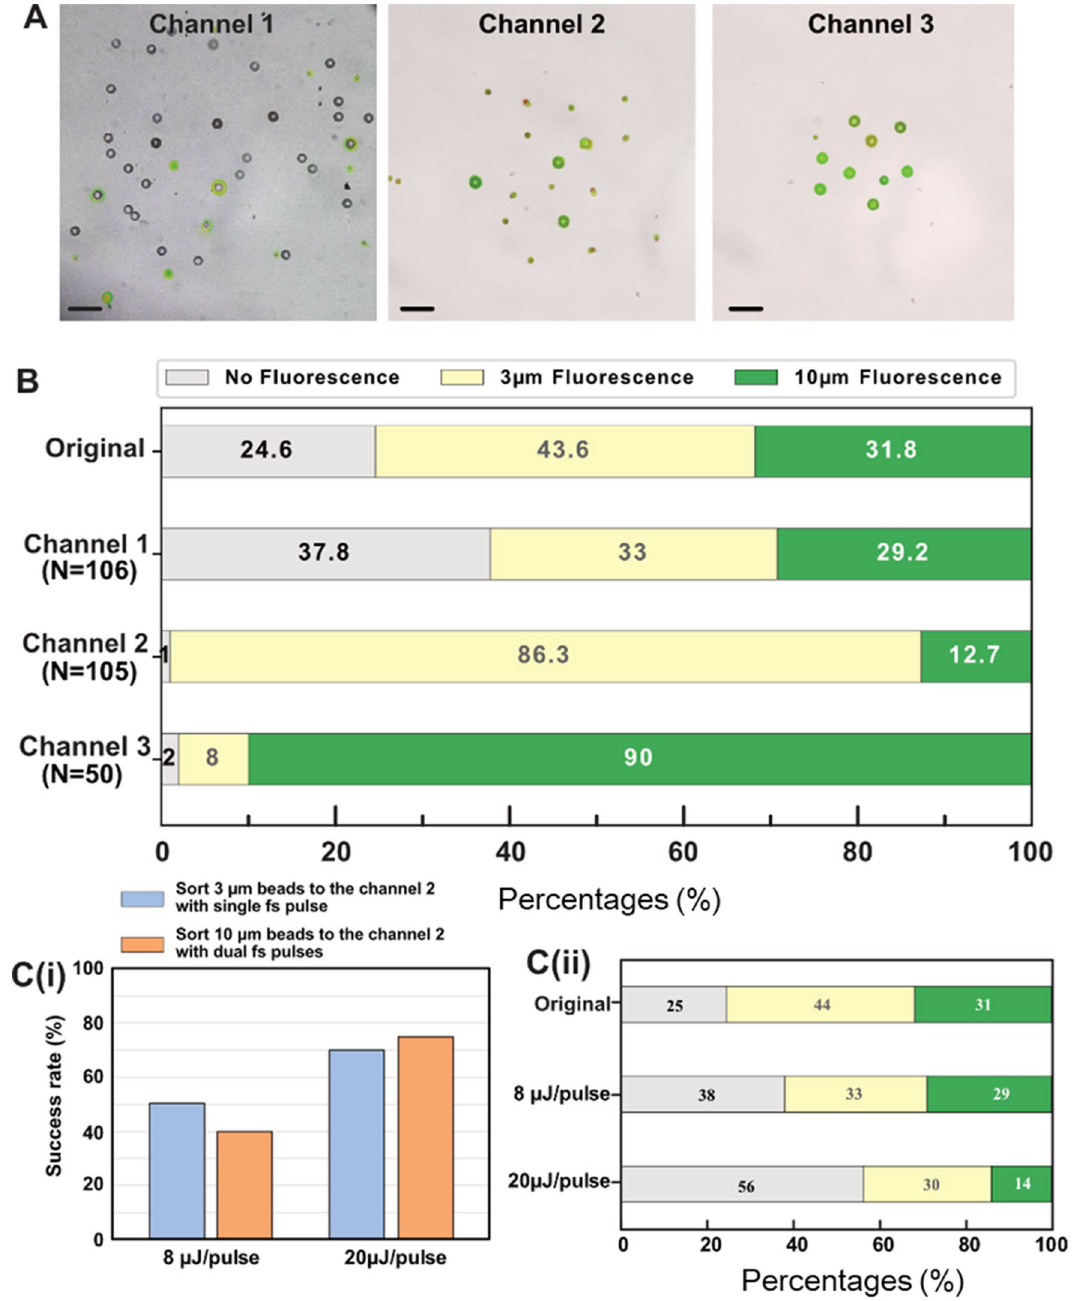
Figure 5. Summarized evaluation of the performance of the femtosecond-laser-assisted triple-selective system using polystyrene beads. ( A ) Photographs of the beads exiting three channels following sorting. ( B ) Percentages of nonfluorescent beads, 3 μm fluorescent beads and 10 μm fluorescent beads to the total number of beads at the outlet of each channel in the original suspension and following sorting. ( C ) (i) Success rate at different pulse energies (n = 20). (ii) Percentages at different pulse energies. The scale bars represent 40 fluorescence intensity and to count cells at the outlet of each channel. In the sorting area, PC-12 cells flowed at a velocity of 200 mm/s during the sorting process. For each of the femtosecond pulses, 8 μJ/pulse was set, as in bead sorting. The sorting procedure is shown in Supplementary Movies S3 and S4. Cell sorting performance was assessed by measuring the percent ratio of nonfluorescent, weakly fluorescent, and strongly fluorescent cells to the total number of cells in each channel output, as illustrated in Fig. 6B. Because nonfluorescent cells were unable to activate the detection system, they would continuously flow into Channel 1, resulting in 46.4% nonfluorescent cells being found at that channel outlet (19.6% in the original mixture). In the case of weakly fluorescent PC-12 cells (i.e., 34.1% in the original mixture), they were capable of triggering a voltage signal greater than 2.5 V, so a single femtosecond pulse was activated to direct cells into Channel 2.